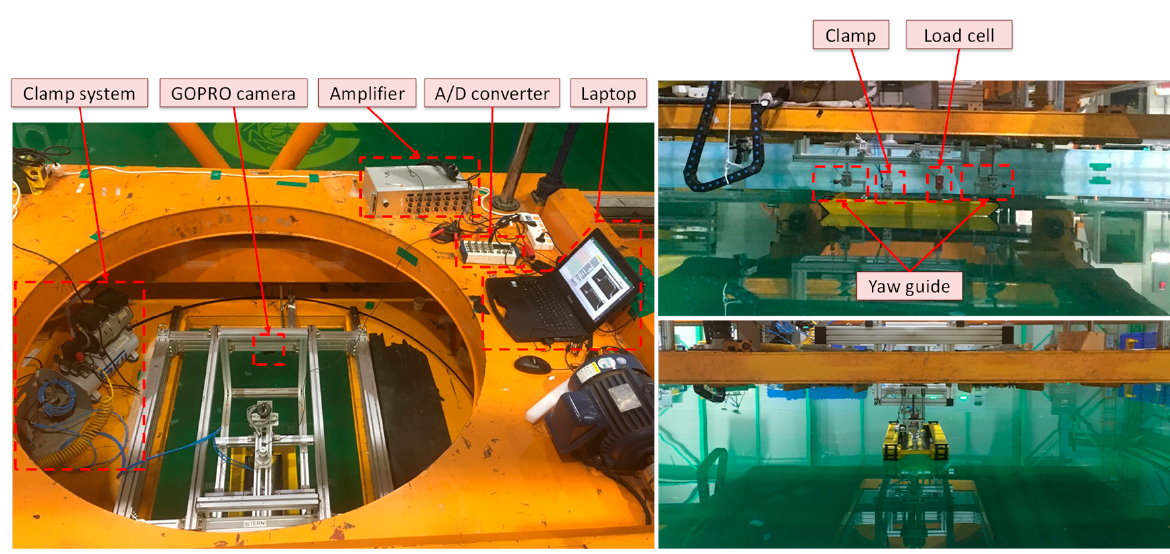
Figure 12. Experimental setup for resistance test.